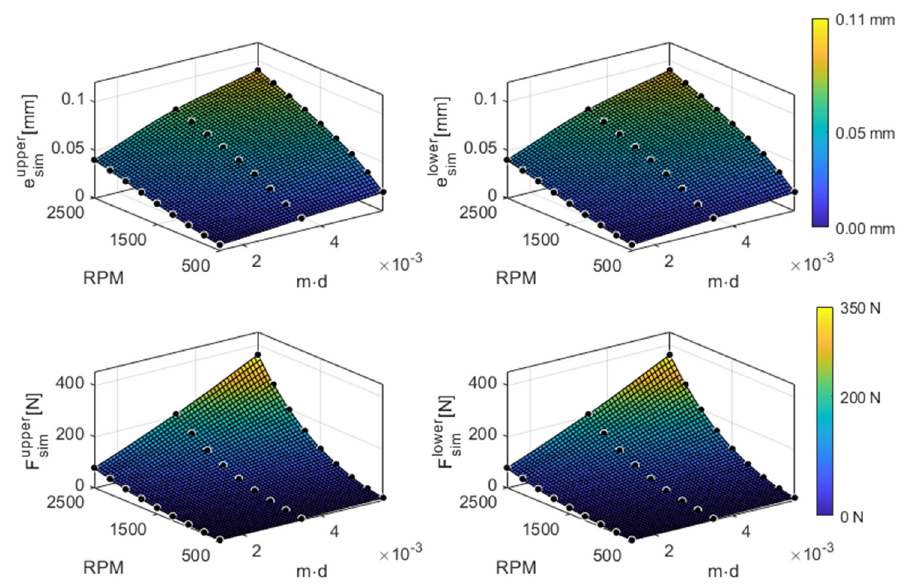
Figure 14. Summary of the simulation result showing the mean values of the resultant displacement and reaction forces for the upper and lower bearings. The data points are shown with black circles.